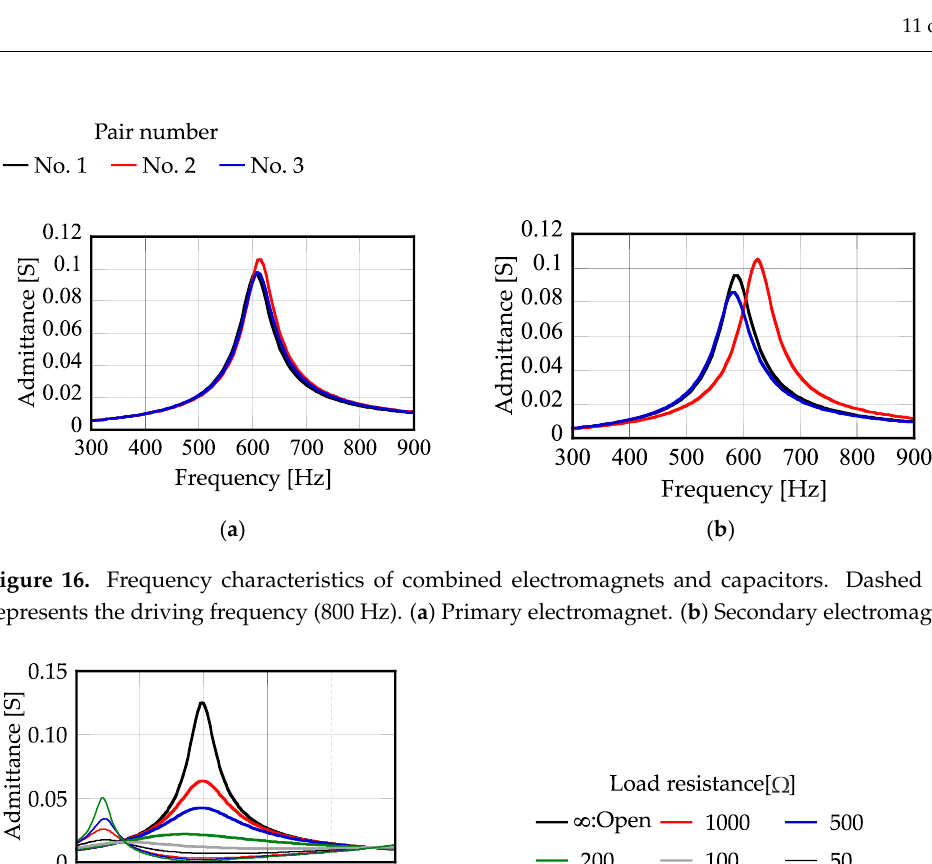
Figure 17. Frequency characteristics of admittance with respect to load resistance.